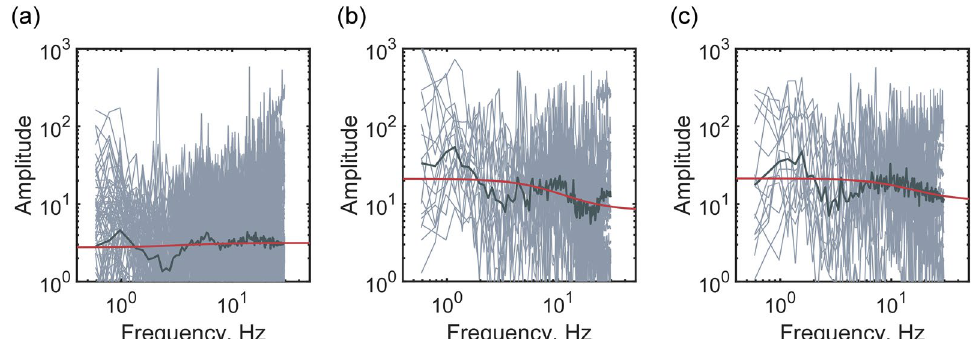
Fig. 8 Example of spectral ratios. a Spectral ratio removed according to selection criteria. b , c Spectral ratios show unusually large stress drop